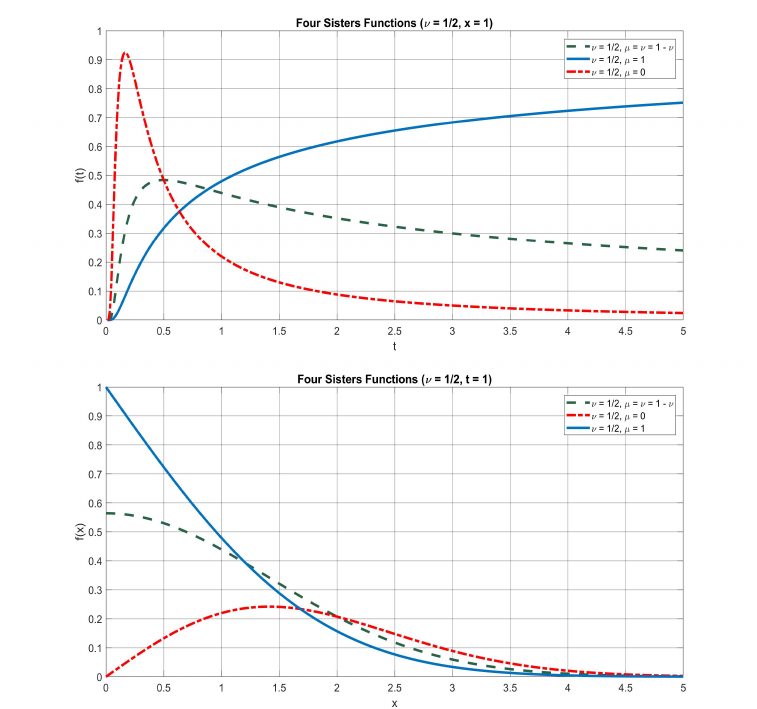
Figure 8. Plots of the three sisters functions in linear scale with ν = 1/2; top: versus t ( x = 1), bottom: versus x ( t =